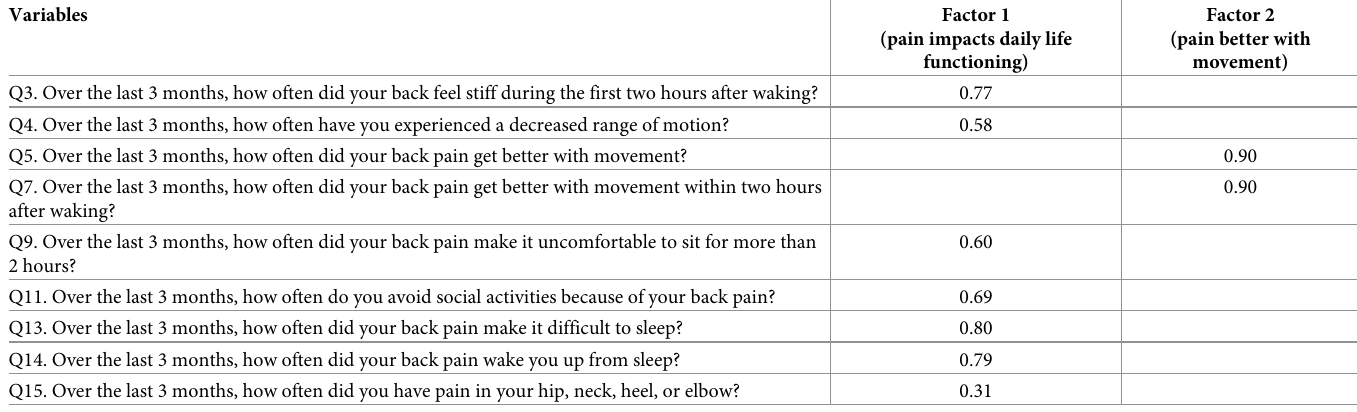
Table 5. Results of rotated factor loadings of exploratory factor analysis.